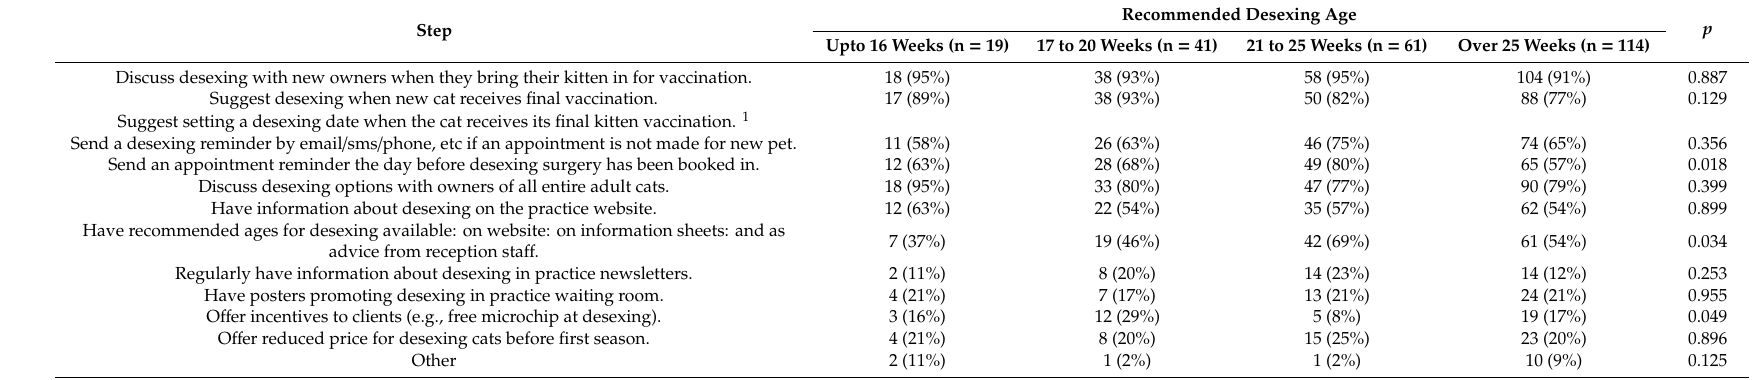
Table 5. Percentages of 235 Queensland veterinary practices that used various steps to promote desexing of cats with respect to recommended desexing age for cats. Recommended Desexing Age p Step Upto 16 Weeks (n = 19) 17 to 20 Weeks (n = 41) 21 to 25 Weeks (n = 61) Over 25 Weeks (n = 114) Discuss desexing with new owners when they bring their kitten in for vaccination. 18 (95%) 38 (93%) 58 (95%) 104 (91%)